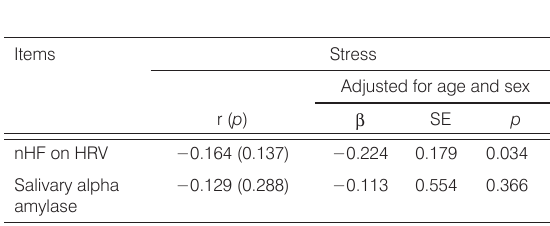
Table 2. Stress and its association with salivary alpha amylase and HRV ( N = 86).